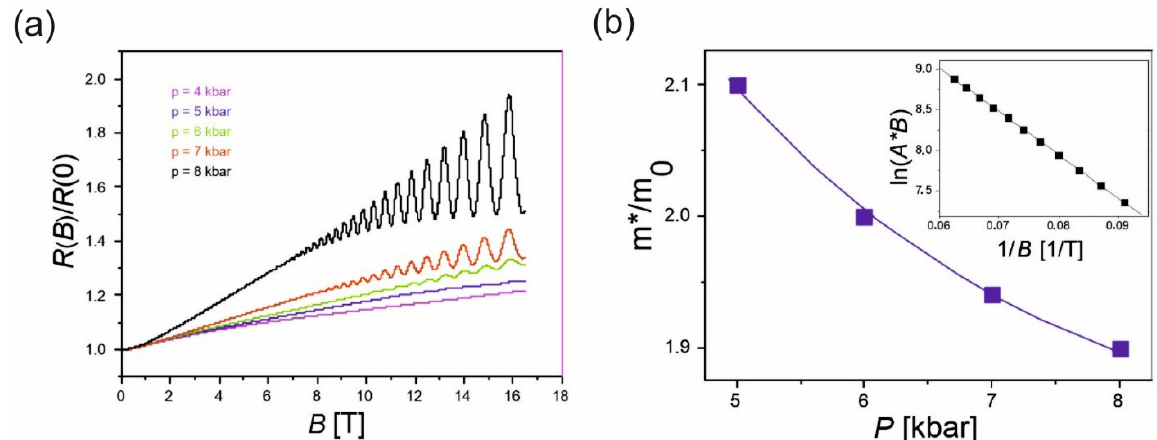
Figure 4. ( a ) Field dependences of the interlayer magnetoresistance at various pressures for T = 0.5 K. The field is perpendicular to the conducting layers. ( b ) Dependence of the relative cyclotron mass on the pressure. Inset: Dependence of the oscillation amplitude on the field in Dingle coordinates ( p = 8 kbar, T = 0.5 K). ( p = 8 kbar, T = 0.5